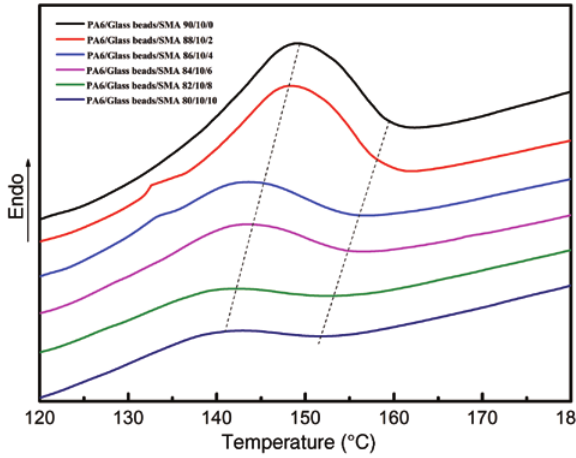
Figure 5 DSC cooling curves of LPA6/glass beads/SMA composites with different contents of SMA.